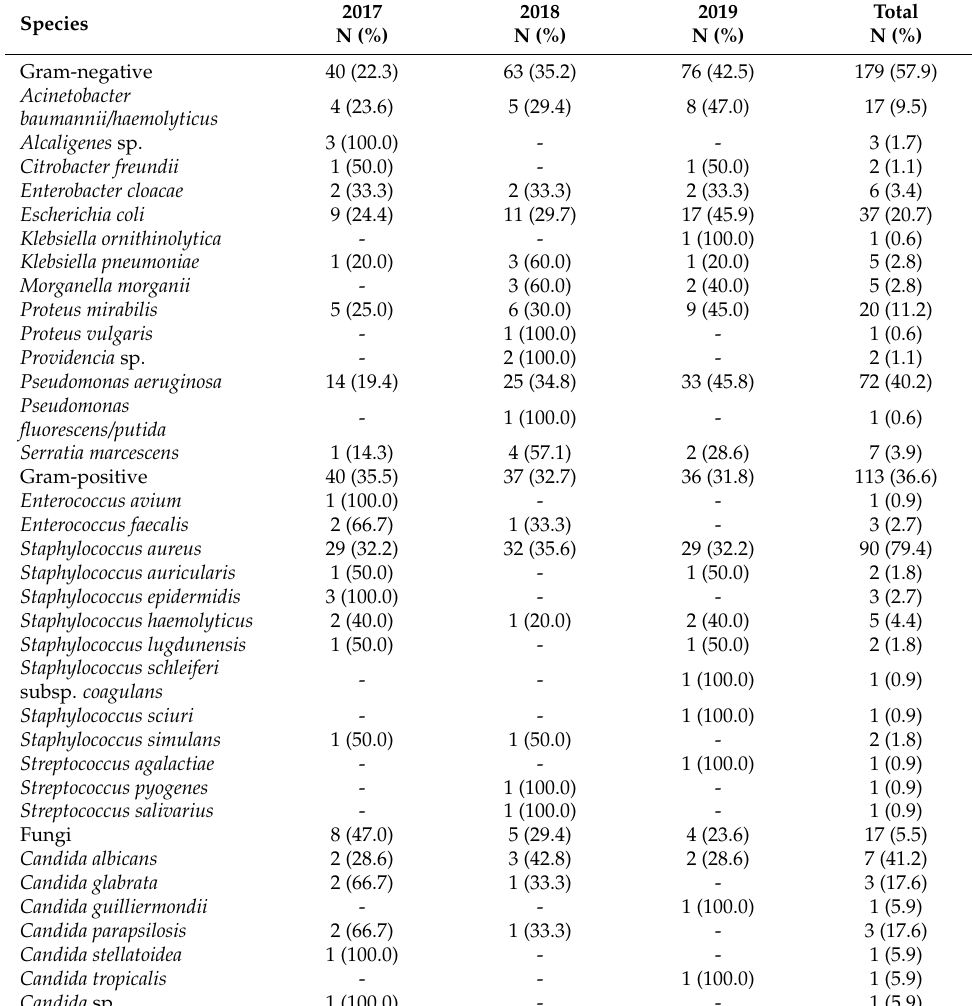
Table 3. Distribution of microorganisms stratified by group and survey’s year.